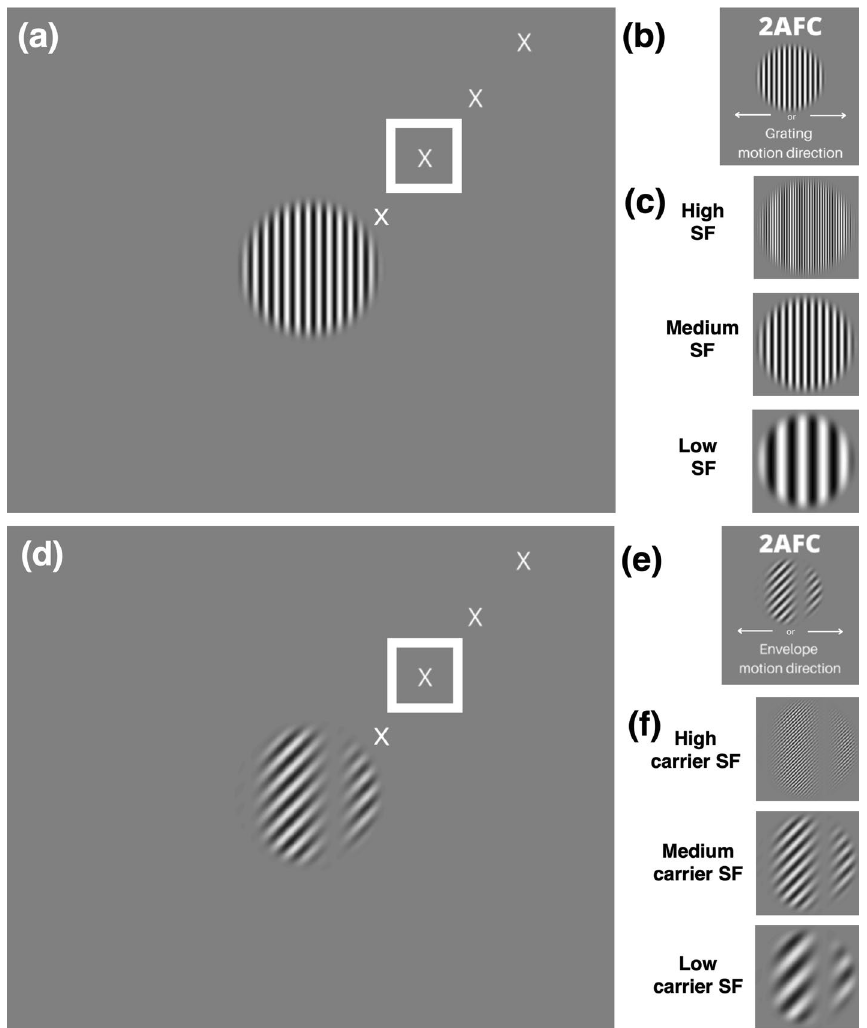
Figure 2. Behavioral task. ( a ) Example luminance modulation (LM) grating stimulus at the center of the screen, with different fixation targets (only one fixation target was visible on any given trial) that would place the stimulus at 2.1°, 4.3° (in a white square), 6.4°, and 8.5° of eccentricity. For illustration purposes, the LM grating stimulus here as well as those in b and c are at higher contrast than those used in the experiments. ( b ) Depiction of the 2-alternative forced choice (2AFC) task in which the subject reported the direction of motion (left vs right) of an LM grating at different spatial frequencies (SFs). ( c ). Example LM stimuli at different SFs. ( d ) Example contrast modulation (CM) stimulus at the center of the screen, with the same fixation targets as in ( a ). ( e ) Depiction of the 2AFC task in which the subject reported the direction of motion (left vs right) of a CM envelope at different carrier SFs. ( f ) Example CM stimuli at different carrier SFs. Fixation targets are slightly enlarged here for illustration